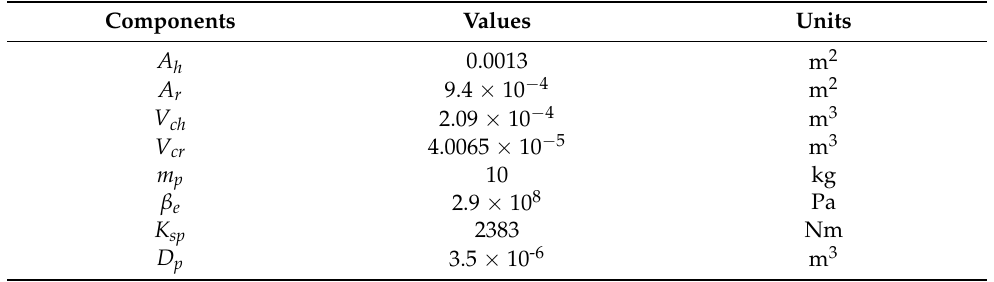
Table 1. Basic parameters of the EHA system.